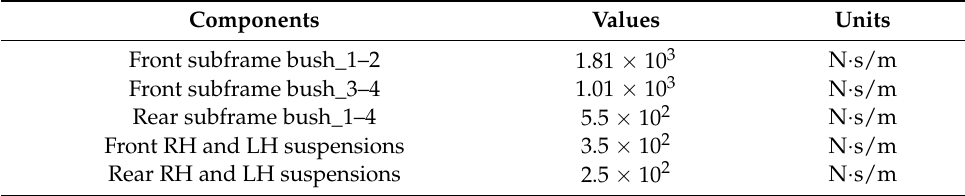
Table 2. Linear damping properties of subframe bushes and